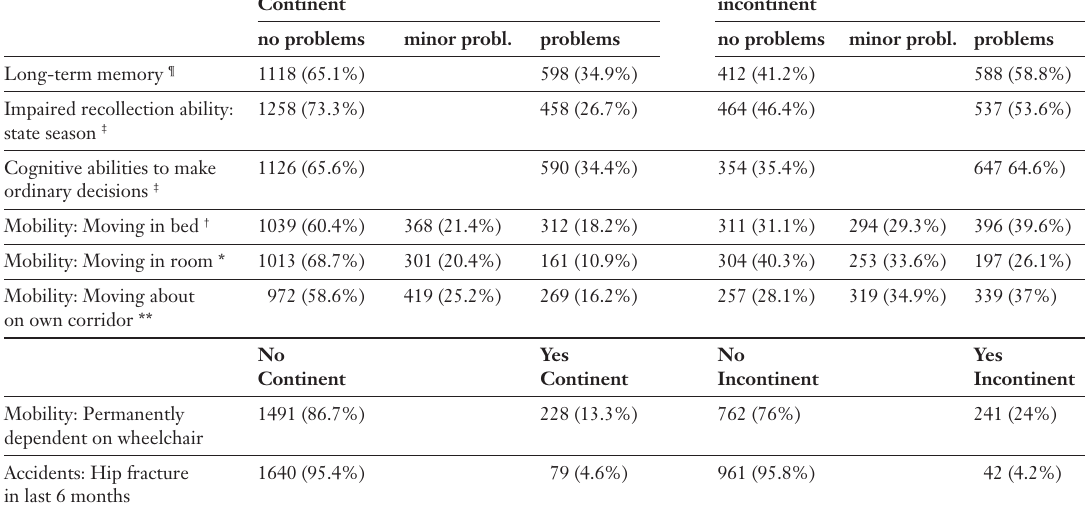
Characteristics of continent and incon- tinent residents at